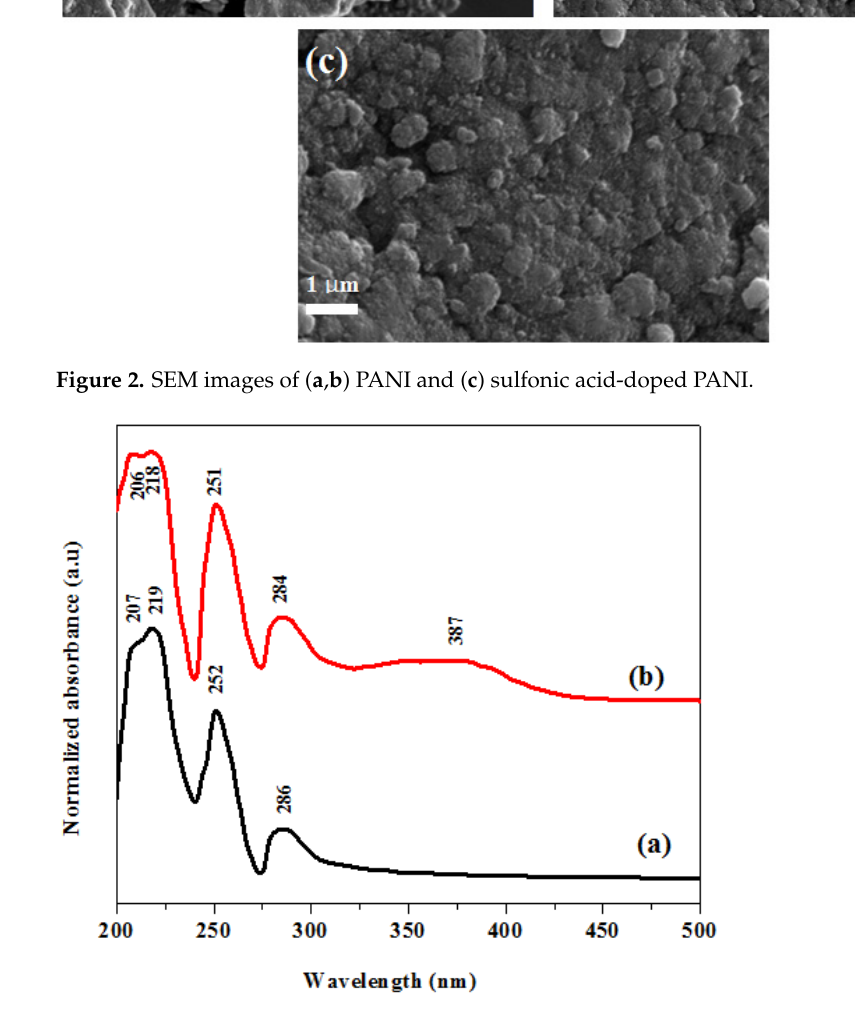
Figure 3. Optical absorption spectra of PANI in the pure ( a ) and doped ( b ) states.